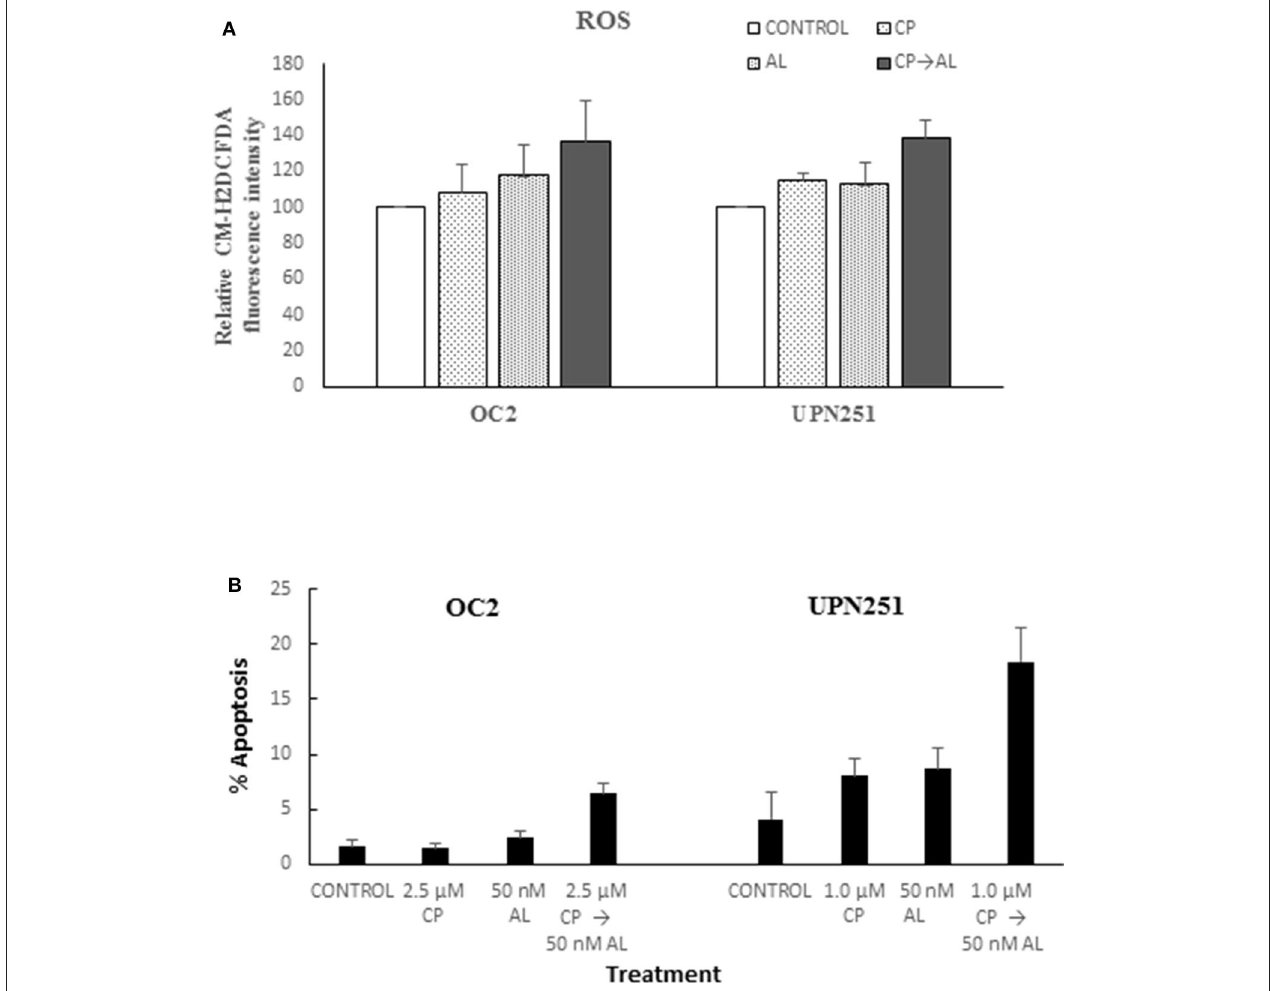
FIGURE 2 | Alisertib enhances ROS accumulation and apoptosis with cisplatin treatment. (A) OC2 and UPN251 cells were treated with 2.5 or 1 µ M cisplatin (CP), respectively, for 3h followed by 50nM alisertib for 48h. Following treatment cells were stained with the fluorescent ROS indicator 5-(and 6-)-chloromethyl-2 ′ , 7 ′ -dichlorodihydrofluorescein diacetate and acetyl ester (CM-H 2 DCFDA, Thermo Fisher Scientific, Waltham, MA) as previously described ( 23). Cellular fluorescent intensity (excitation 488nm, emission 520nm) was acquired using a FACSCalibur (BD Biosciences) flow cytometer. Average fluorescent intensity was calculated using WinList software (Verity Software House, Topsham, ME). Treatment with CP followed by AL led to increased ROS production in both OC2 ( p < 0.05) and UP251 ( p < 0.01) cells compared to the untreated control and treatment with either CP or AL alone. (B) OC2 and UPN251 cells were treated with cisplatin (CP), for 3h followed by 50nM alisertib for 48h. Following treatment cells were stained with Hoechst 33,342 (70 µ g/ml) and propidium iodide (100 µ g/ml) at 37 ◦ C for 15min and apoptotic cells quantified by fluorescence microscopy (21). A minimum of 300–400 cells were counted in each experiment. Treatment with CP followed by AL led to significantly increased apoptosis in both OC2 and UP251 ( p < 0.001) cells compared to the untreated control and treatment either CP or AL alone. Data for ROS and apoptosis are mean ± standard deviation from at least triplicate